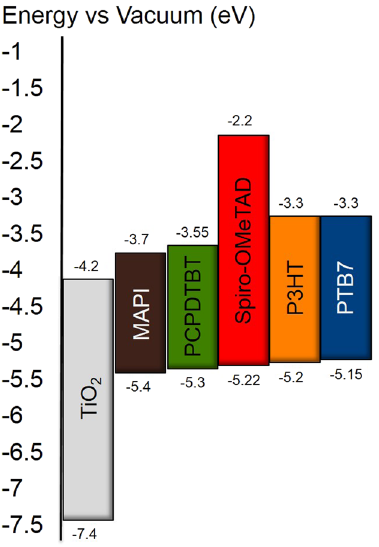
Figure 3. Energy level diagram of the different materials employed.